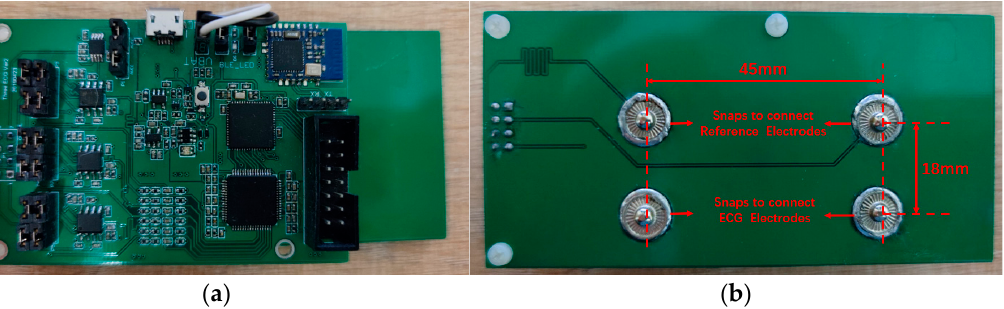
Figure 5. Printed system circuit board; ( a ) top layer of the circuit board; ( b ) bottom side of the circuit board.